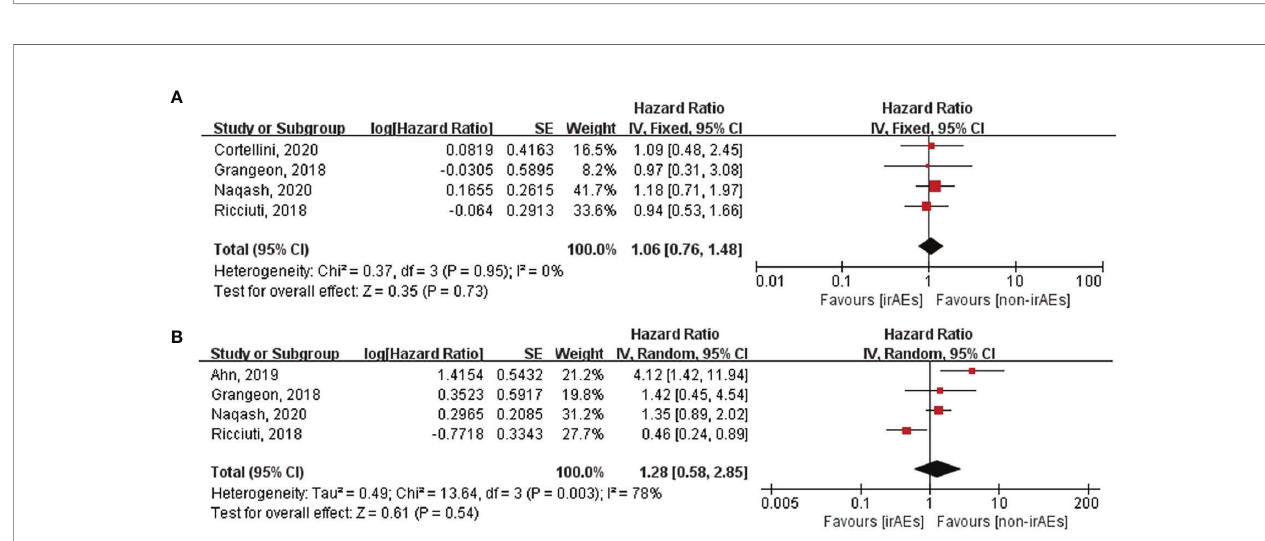
FIGURE 5 | Forest plot of the association between the occurrences of different irAEs types and OS. (A) dermatological irAEs; (B) endocrine irAEs; (C) gastrointestinal irAEs. OS, overall survival; irAEs, immune-related adverse events; non-irAEs, non-immune-related adverse events.